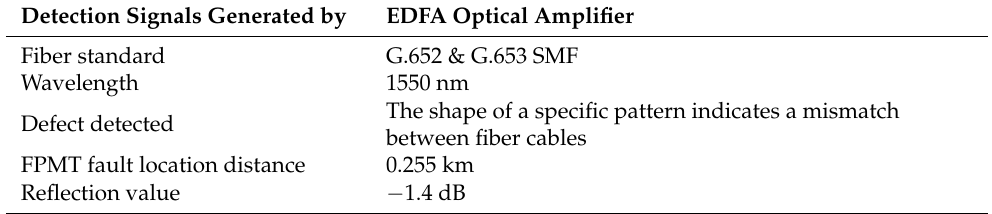
Figure 11. The improving FPMT circuit detected a mismatch between fiber cable patterns at event 5. Table 9. The parameters and practical results detected at event